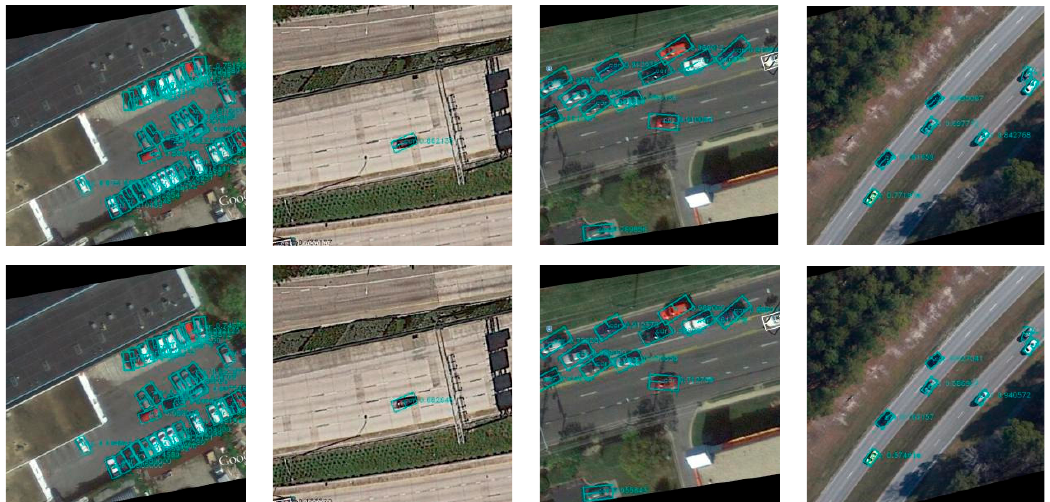
Figure 12. The visual results of car detection. The first row is the detection results of the proposed algorithm, and the second row is the detection results of the comparison algorithm.